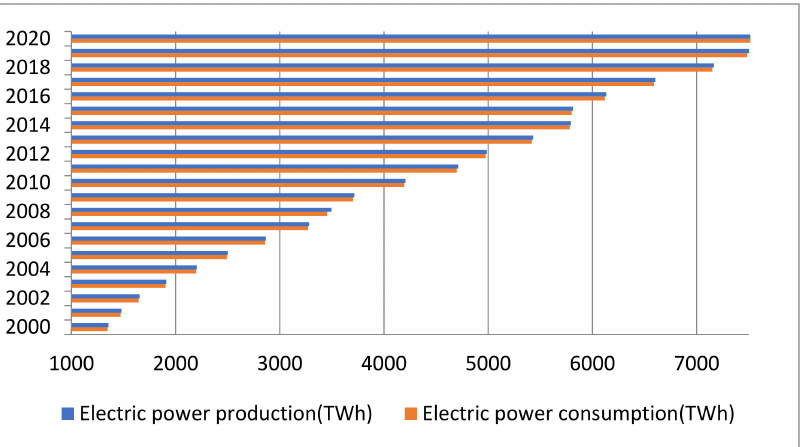
Figure 1. Trend of China’s electric power production and consumption. (Data source: National Bureau of